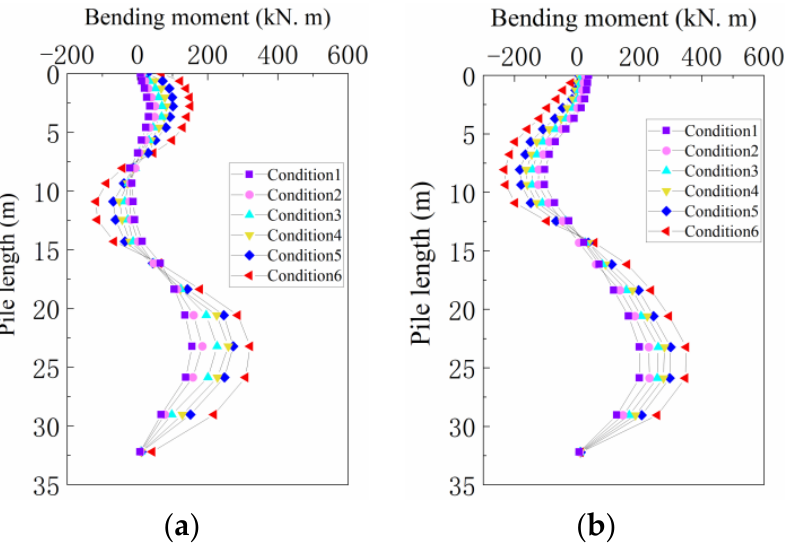
Figure 17. Pile bending moment curves. ( a ) Point A; ( b ) Point B.